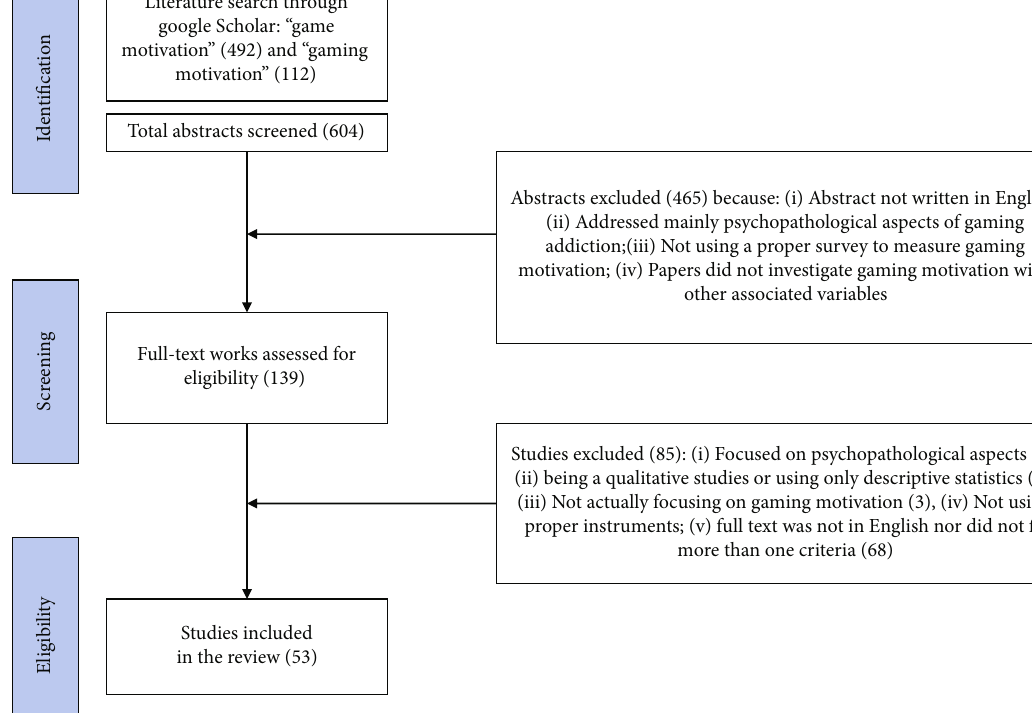
Figure 1: Diagram showing the number of papers identi fi ed, included, and excluded about gaming motivation papers according to the exclusion